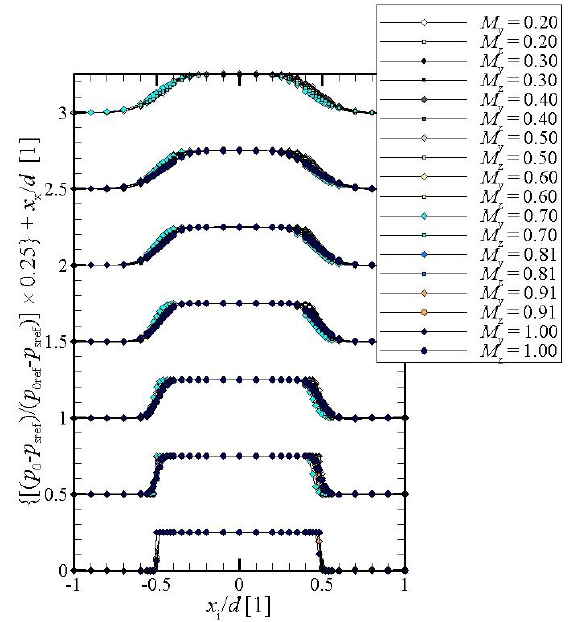
Fig. 5. Cp 0 coefficient distribution in y-z planes in several axial distances x/d e downstream of the subsonic nozzle exit.